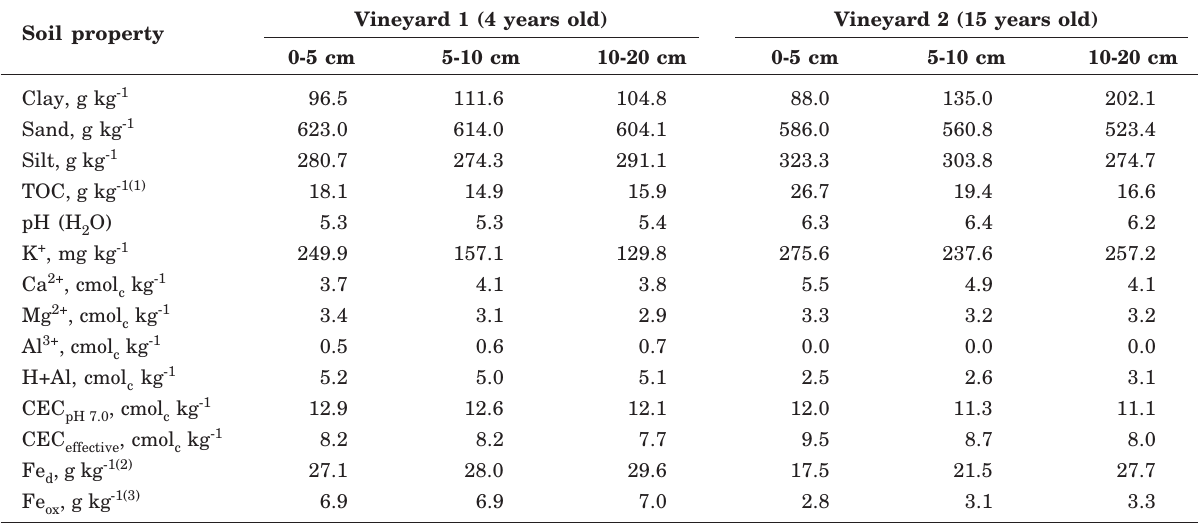
(1) TOC: total organic carbon; (2) Fe